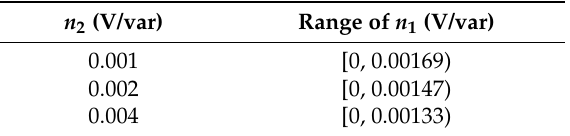
Table 2. The influence of reactive droop coefficients between DG1 and DG2. n 2